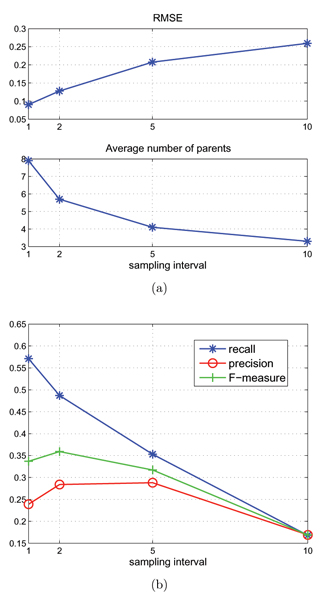
Robustness of the nonlinear model when varying the sampling interval. Plots of the RMSE and average number of parents (a), and recall, precision and F-measures (b) of the nonlinear model corresponding to α = 0.8, as a function of the sampling interval s (in minutes).